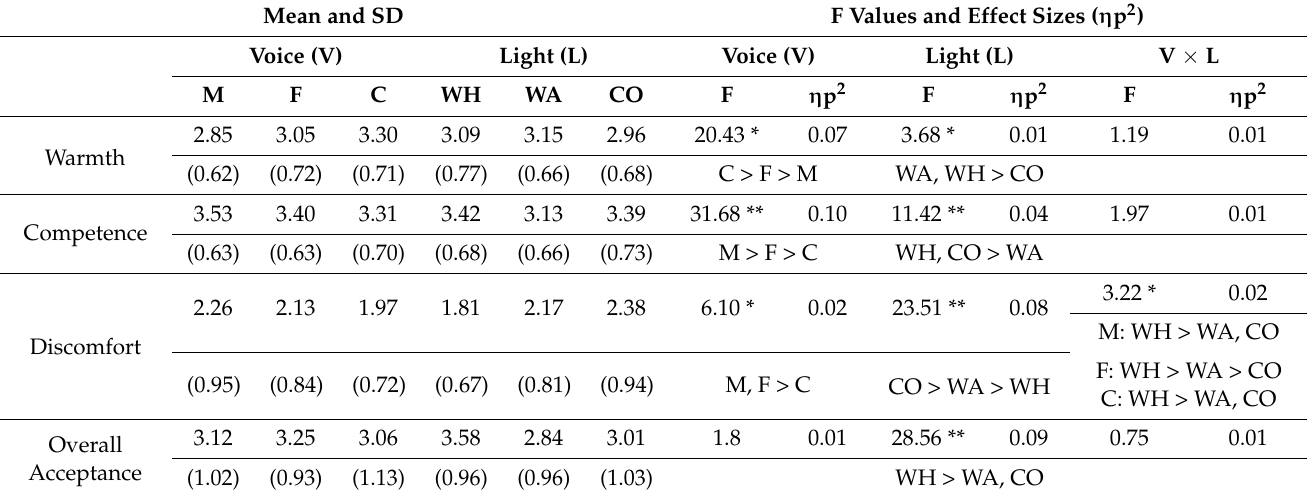
Table 5. Results of the